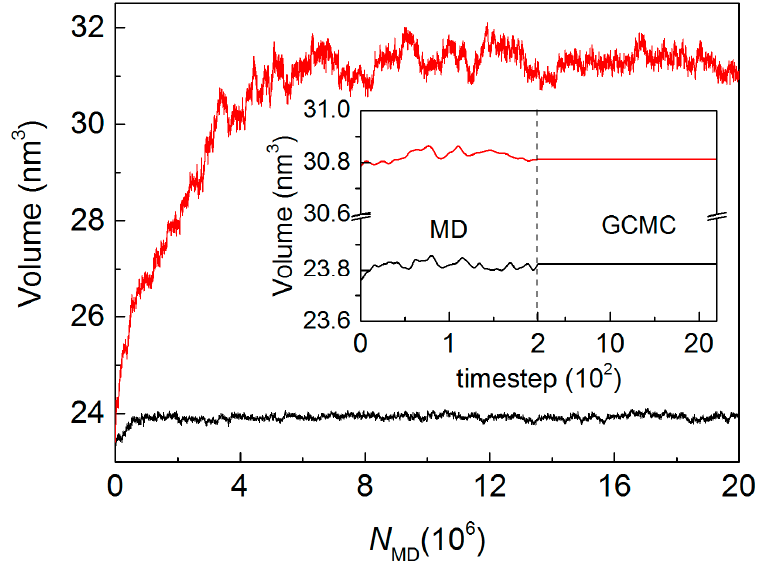
Figure 6. Volume in nm 3 as a function of MD steps as obtained from hybrid GCMC/MD simulations. The data obtained for a relative humidity RH = 0.025 (black data) and RH = 1 (red data) are shown. The insert, which shows a zoom corresponding to the end of the hybrid simulation, illustrates how the volume fluctuates around its equilibrium value in the course of a block consisting of a MD segment and a GCMC segment (the volume does not change during the GCMC segment as only the energy and number of molecules are allowed to change).